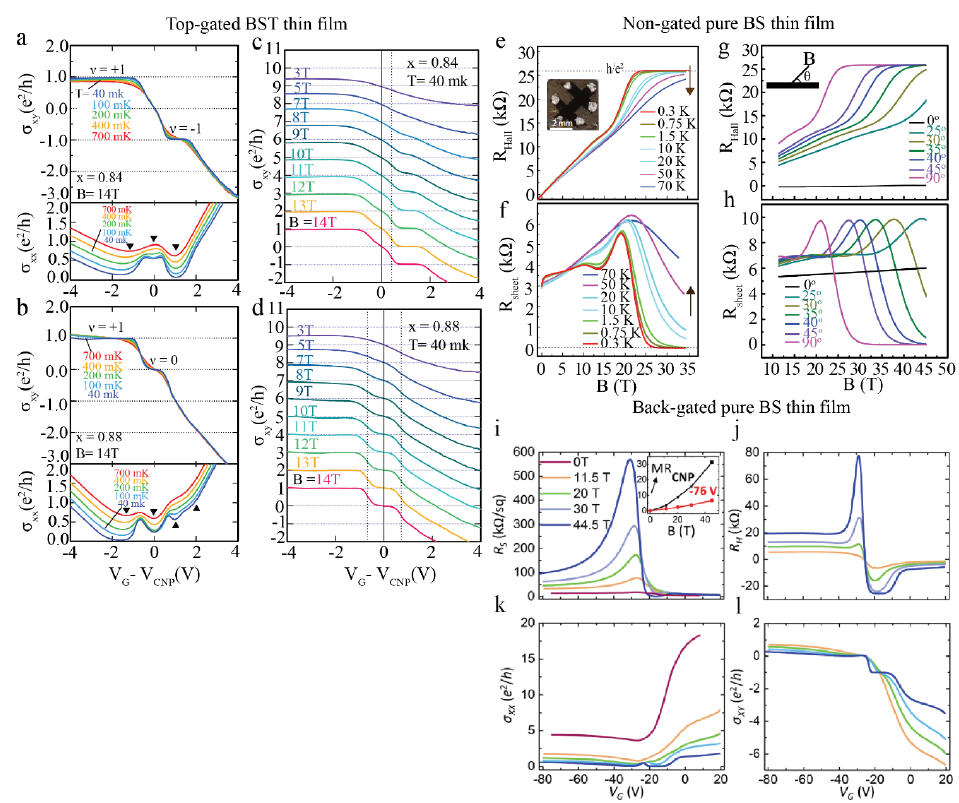
Figure 3: QHE in MBE-grown TI films . Gate voltage ( V - V ) dependence of ex- G CNP tracted 2D σ and σ at various temperatures from 40 to 700 mK in magnetic field xx xy of 14 T for a top-gated MBE-grown 8 QL-thick film of a, (Bi Sb ) Te where LLs 0.16 0.84 2 3 of top and bottom surface are degenerate and ν = ± 1 plateaux are measured and b, (Bi Sb ) Te with slightly different top and bottom surface (due to insertion of a 0.16 0.84 2 3 1 QL-thick Sb Te buffer-layer between the film and InP substrate), which is believed 2 3 to lead to non-degenerate LLs of top and bottom surface, thus asymmetric ( ν = 0 and 1) plateaux. The corresponding dips in σ are also marked. c, and d, Magnetic xx field dependence of σ for each sample, measured at 40 mK. Figures (a), (b), (c), xy and (d) are adapted from ref. [ 69 ] . e, Magnetic field dependence of R at different xy temperatures in magnetic field up to 34.5 T for a non-gated 8 QL-thick buffer-layer- / Se capping, which exhibits perfect quantization at h based Bi Se film with MoO at 2 3 3 e 2 low temperatures. f, Magnetic field dependence of R , which vanishes (0.0 ± 0.5 xx Ω ) when Hall resistance quantizes to h / e 2 . The signature of QH persists up to 70 K. (e) and (f) are adapted from ref. [ 57 ] . The corresponding angle dependence for g, R and h, R QHE. i, R and j, R at T = 0.35 K as a function of gate voltage xy xx xx xy V at several magnetic field values from 0 to 44.5 T for a back-gated 10 QL-thick G / Se capping adapted from ref. [ 261 ] . Cor- buffer-layer-based Bi Se film with MoO 2 3 3 responding k, sheet ( σ ) and l, Hall ( σ ) conductance. ν = 1 QHE is observed at xx xy ≈ − 15 V to − 20 V and non-saturating magnetoresistance with B is observed for V G ≤ − 21 V as plotted in the inset of (i) for CNP and V = − 76 V G G